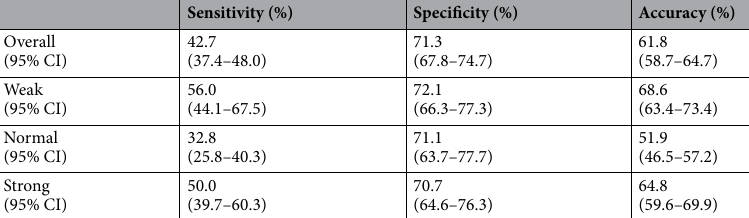
Table 5. Measures of sensitivity, specificity, and accuracy of radial pulse strength. Spearman’s rank correlation coefficient: rs = 0.288, P < 0.001. SBP systolic blood pressure, PR pulse rate, bpm beats per minute. We defined ‘weak’, SBP = 80 mmHg; ‘normal’, SBP = 120 mmHg; and ‘strong’, SBP = 180 mmHg. SPB 0 mmHg and PR 0 bpm data were excluded (n = 45). Incorrect answers regarging the presence of radial pulse were excluded (n = 32). CI confidence